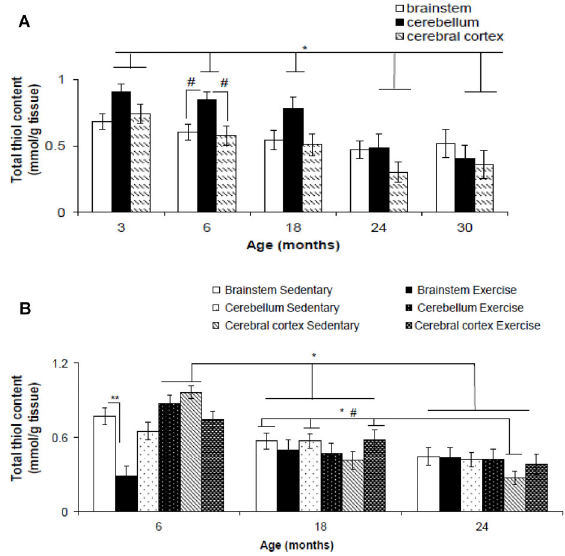
Figure 4. Total thiol content in the brainstem, cerebellum, and cerebral cortex of Wistar rats of different ages ( A ) and after 12 weeks of treadmill running ( B ). Data are reported as means ± SE. *P o 0.05, two- or three-way ANOVA; # P o 0.05 two- or three-way ANOVA; **P o 0.05, three-way